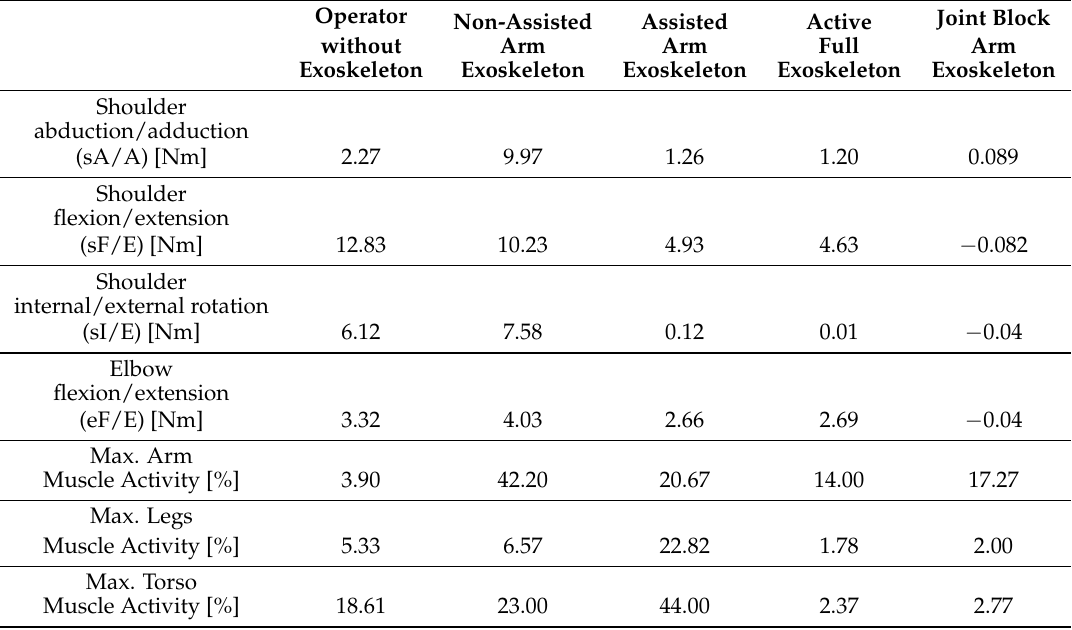
Table 3. Results obtained from the inverse dynamic analysis in AnyBody TM for the musculoskeletal model of the human